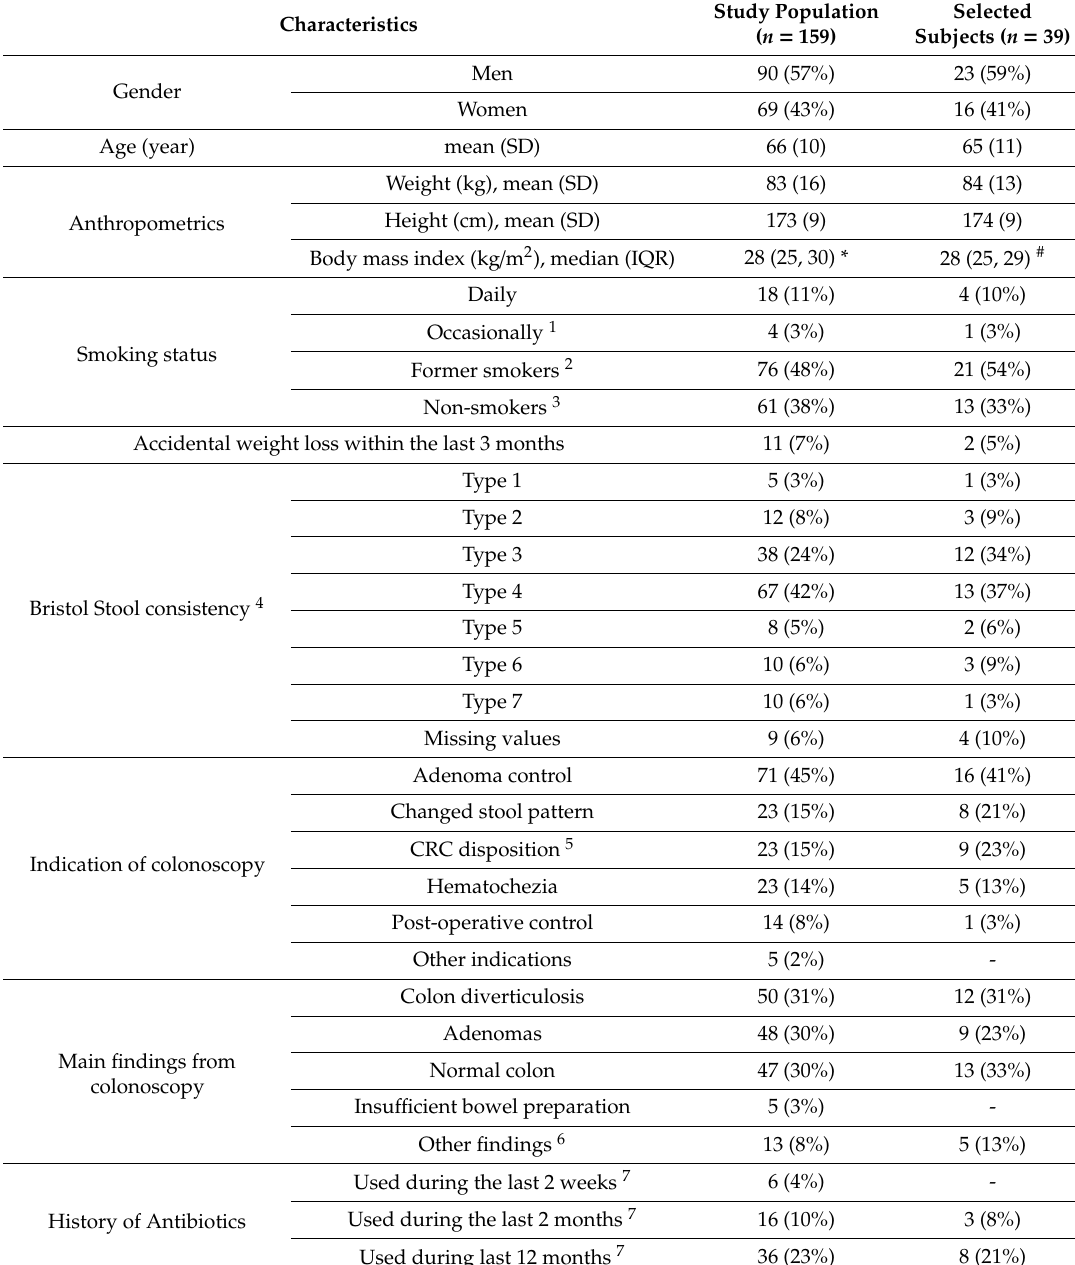
Table 1. Demographic and clinical characteristics of the study population ( n = 159), and the sample used for the analyses of the relation between diet and mucus thickness ( n =